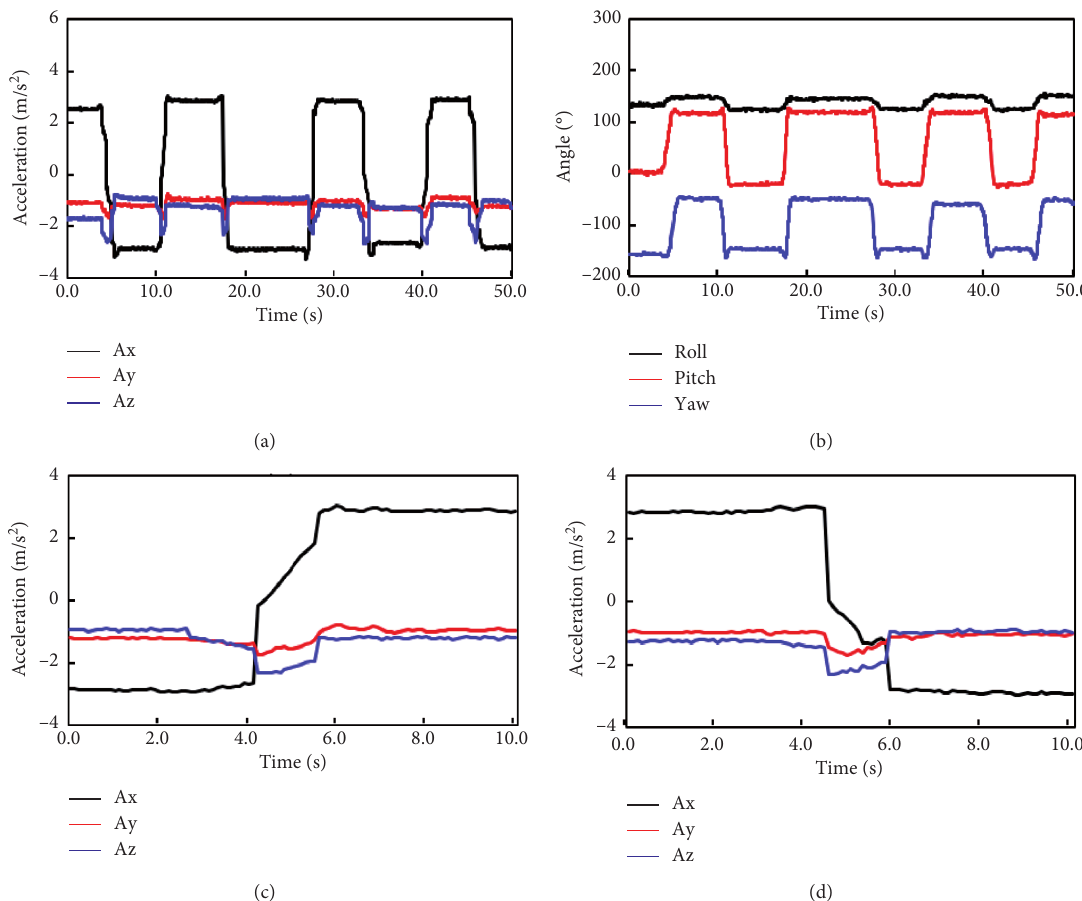
Figure 9: Movement data when the head is turned left and right. (a) Head motion acceleration diagram. (b) Head motion angle diagram. (c) Head left rotation acceleration diagram. (d) Head right rotation acceleration